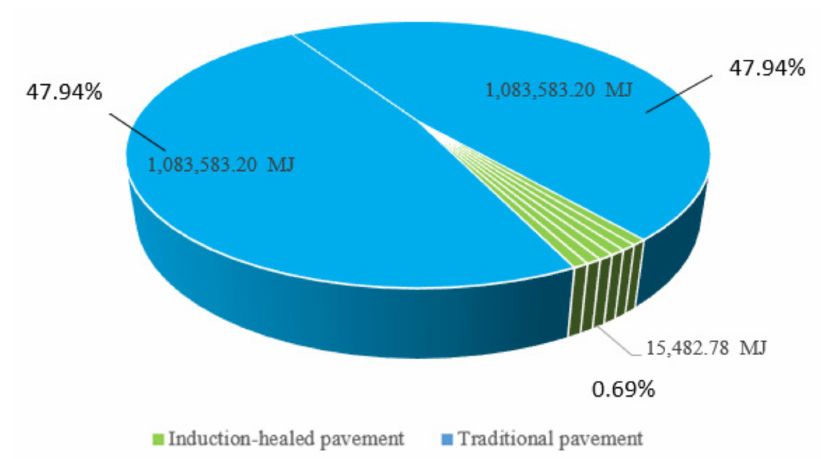
Figure 5. Energy consumption of two overhauls of traditional pavement and six electromagnetic induction (EMI) maintenance sessions of induction-healed pavement.